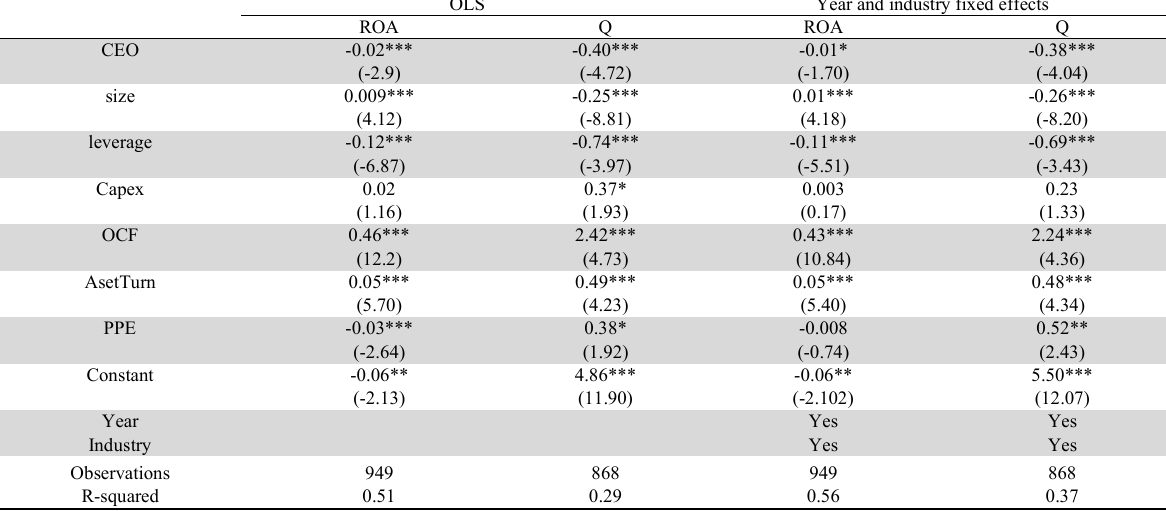
Regression results comparing performance between firms manged by foreign CEO and local CEO